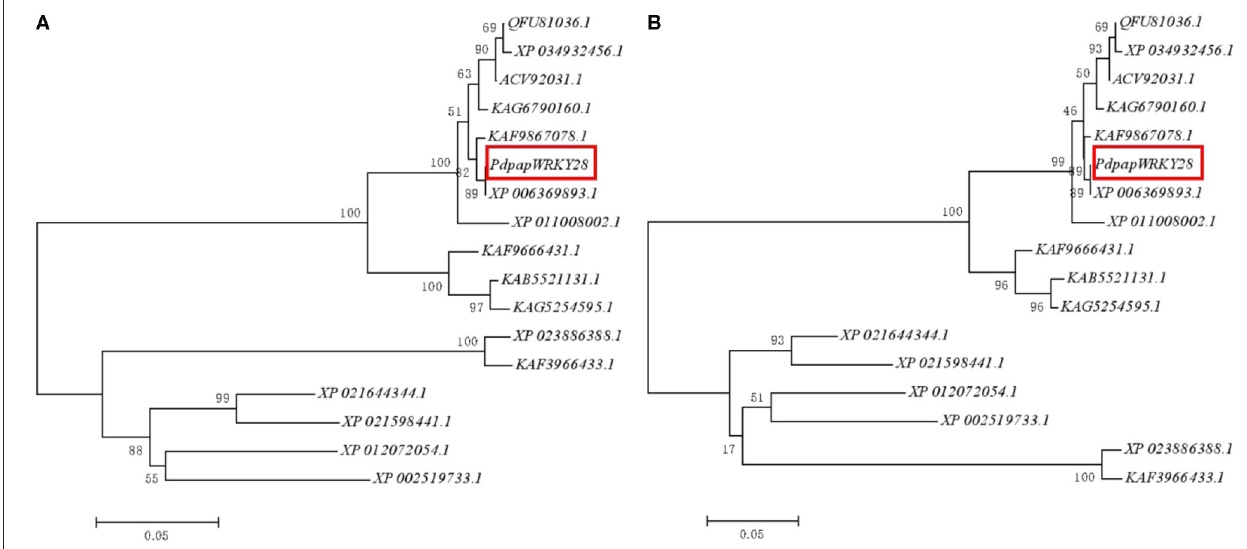
FIGURE 4 | Dendrogram of the PdPapWRKY28 gene family proteins. (A) Neighbor joining (NJ)-phylogenetic tree; (B) Maximum likelihood (ML)-phylogenetic tree. The dendrogram was constructed using the MEGA5 with the neighbor method and Poisson model. The PdPapWRKY28 gene is marked with a red frame, and the results showed the same evolutionary relationship under the two algorithms.